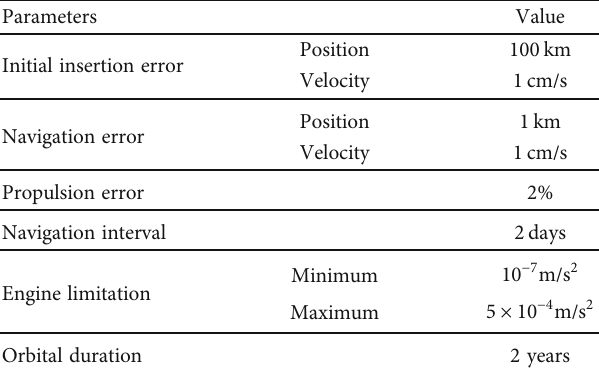
Figure 8: The station-keeping for the nominal orbits with the SRP as the perturbation. Table 3: The constraints and other